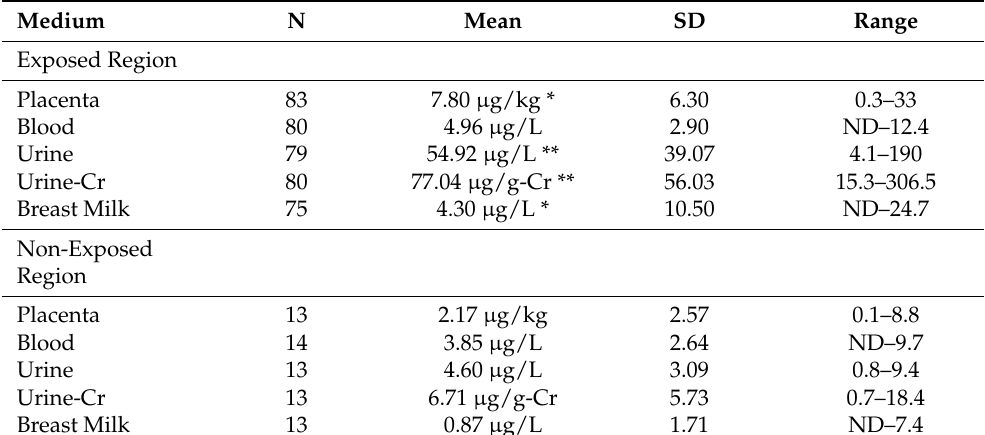
Table 2. Arsenic levels in biological samples in mothers from the main study.